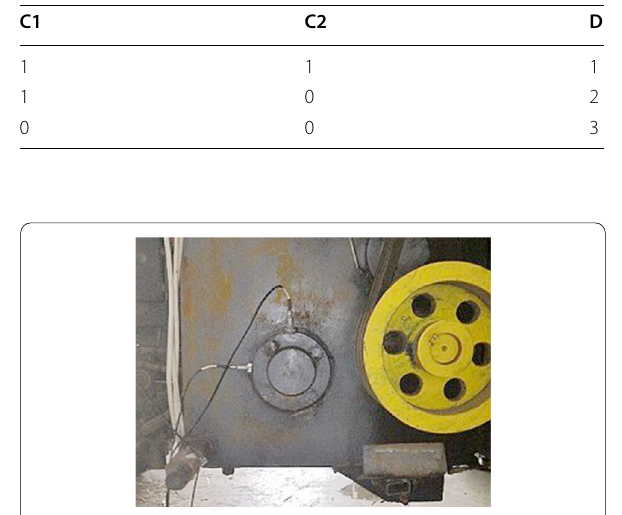
Figure 5 Acquisition of vibration signals from the gearbox of a